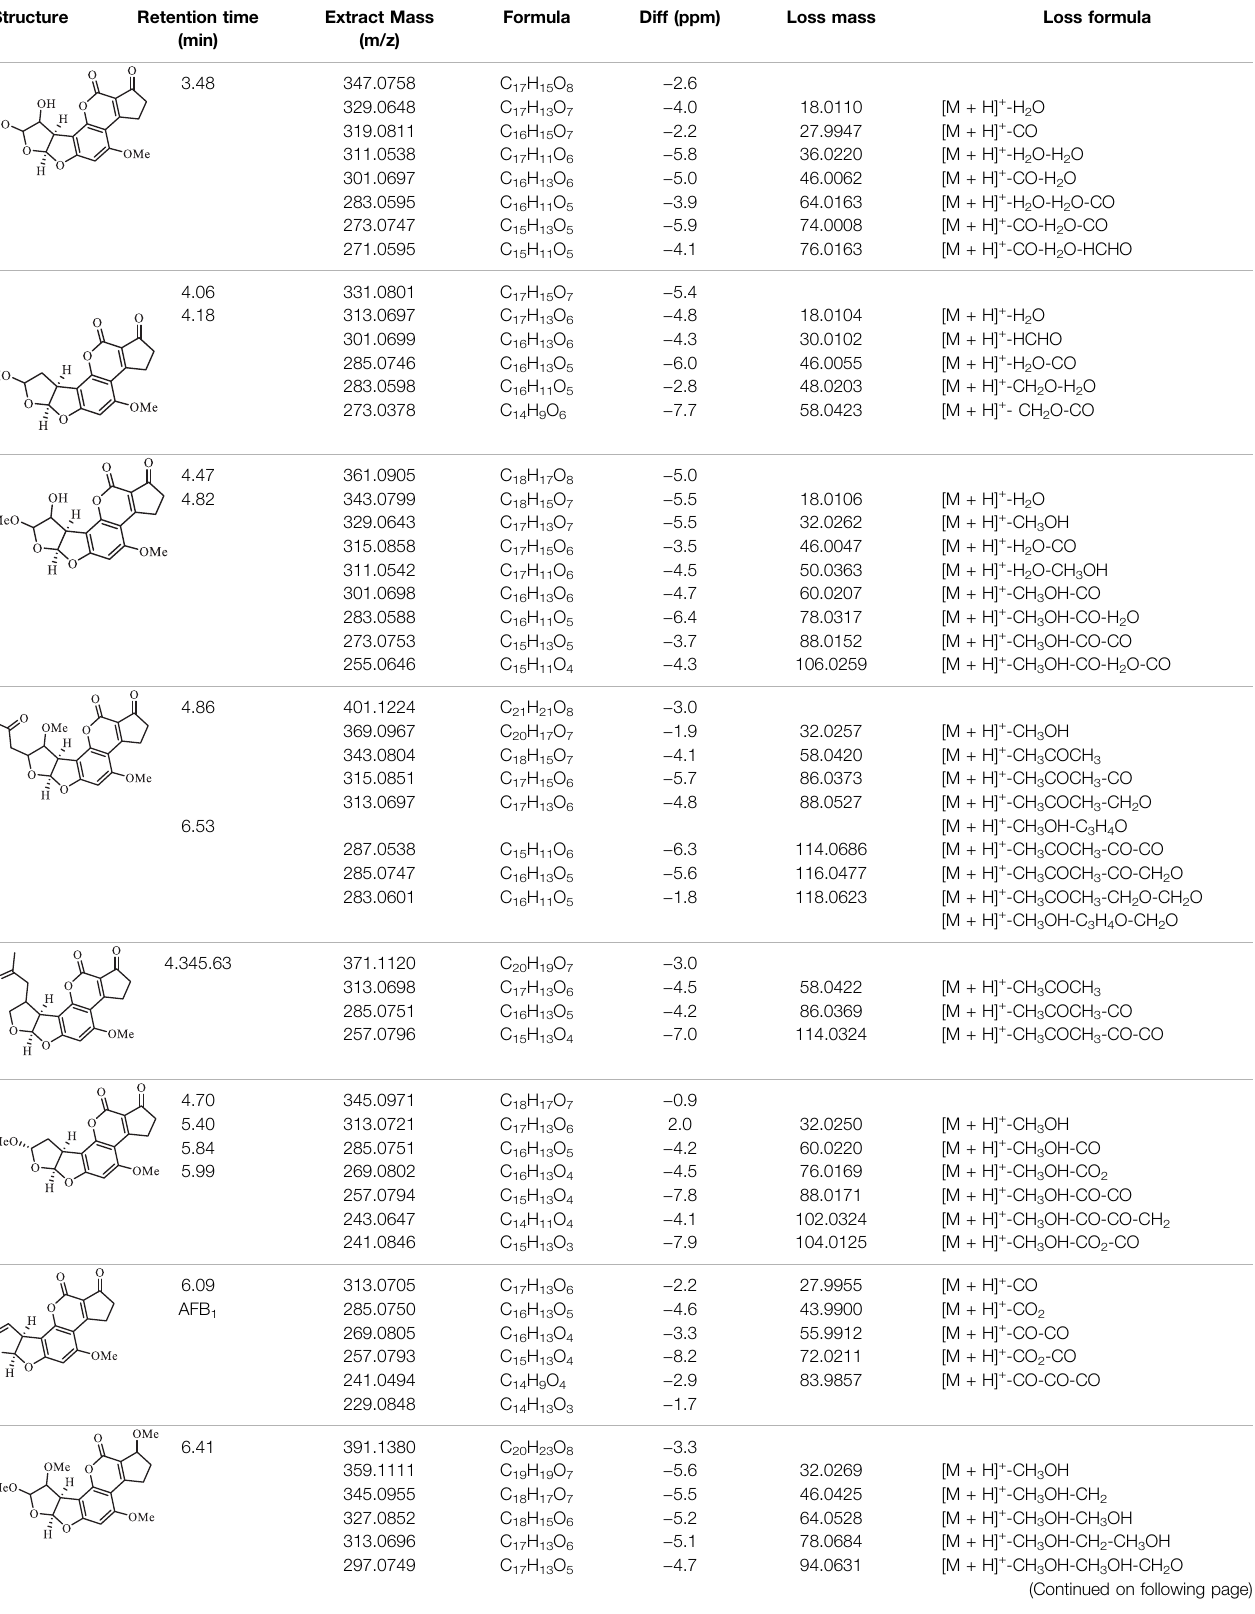
TABLE 1 | HR-ESI and MS/MS data of seventeen degraded products and a fl atoxin B 1 .